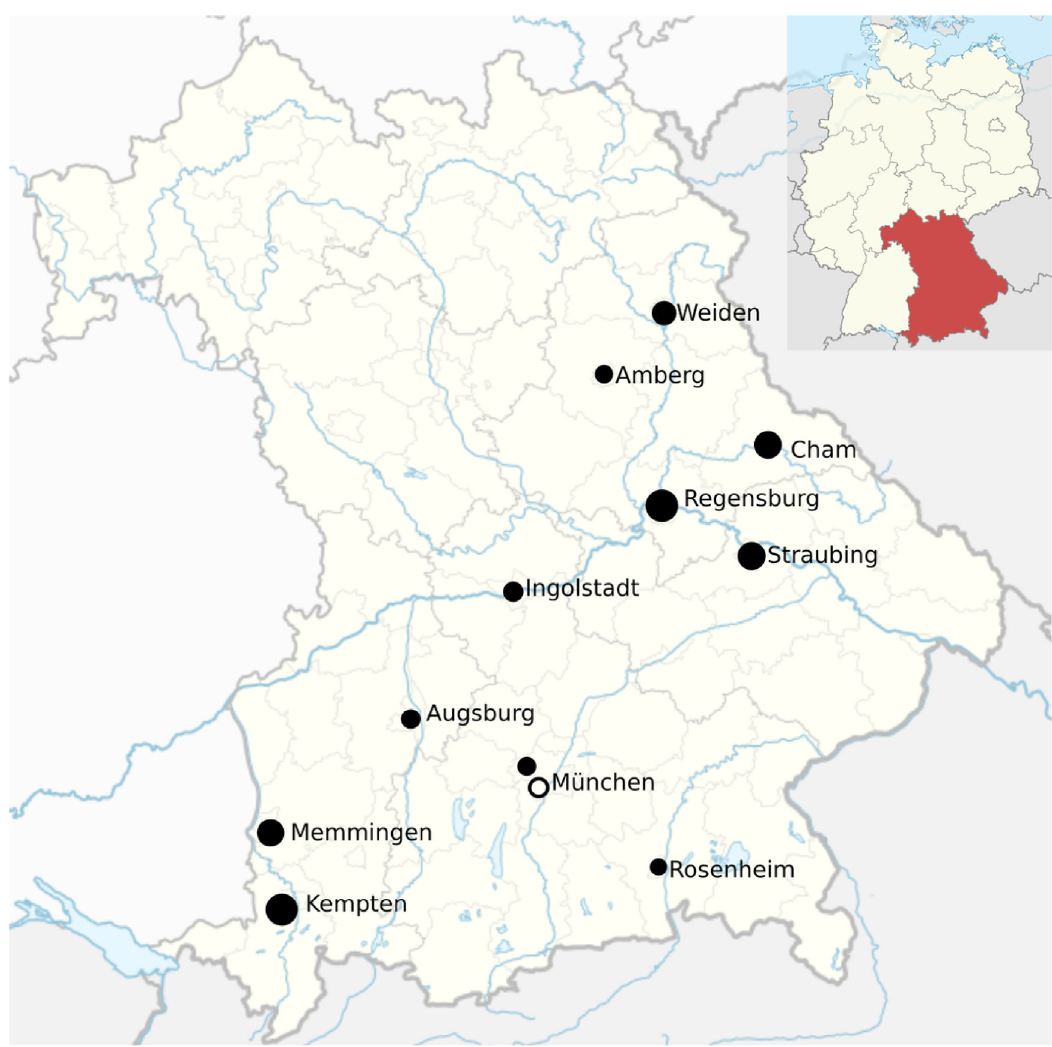
Fig 1. Locations of participating EDs. The map locates the participating EDs within Bavaria, South-Eastern Germany. EDs participating in both seasons are depicted as filled dots, unfilled dots represent EDs participating in 2020/2021 only. Dot size is proportional to the number of returned surveys from each